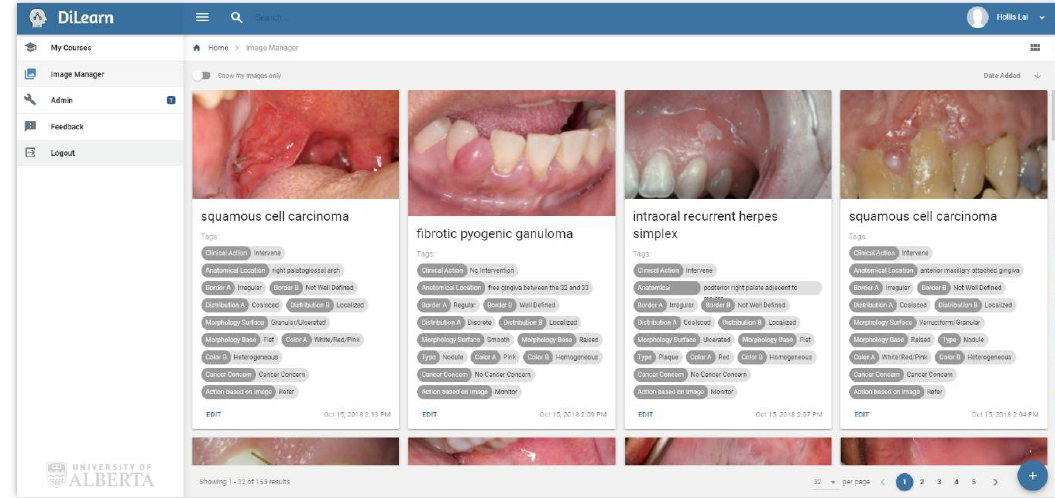
Figure 1. An image bank with its corresponding tags.